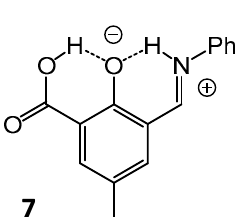
Figure 5. Schematic structure of ortho -hydroxyaryl Schiff base 7 , studied by NMR in [51].